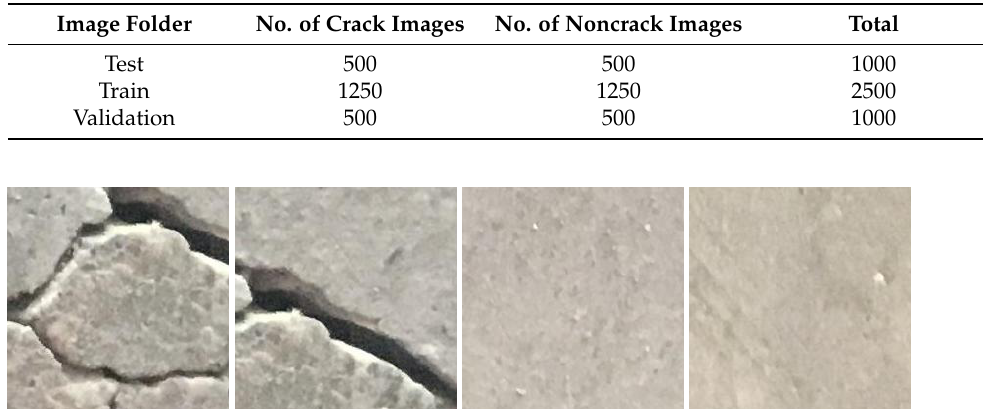
Table 6. Summary of external dataset (BWCI).